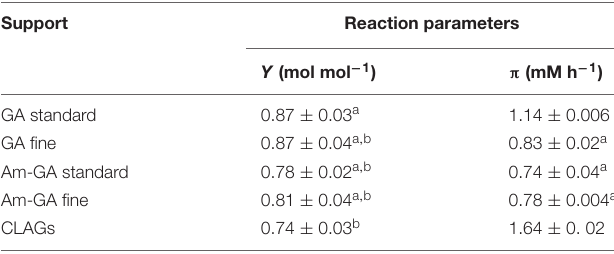
TABLE 2 | Product yield ( Y ) and productivity ( π ) of butyl- β -galactoside synthesis with immobilized β -galactosidase from Aspergillus oryzae in acetone/1- butanol/aqueous solution ternary